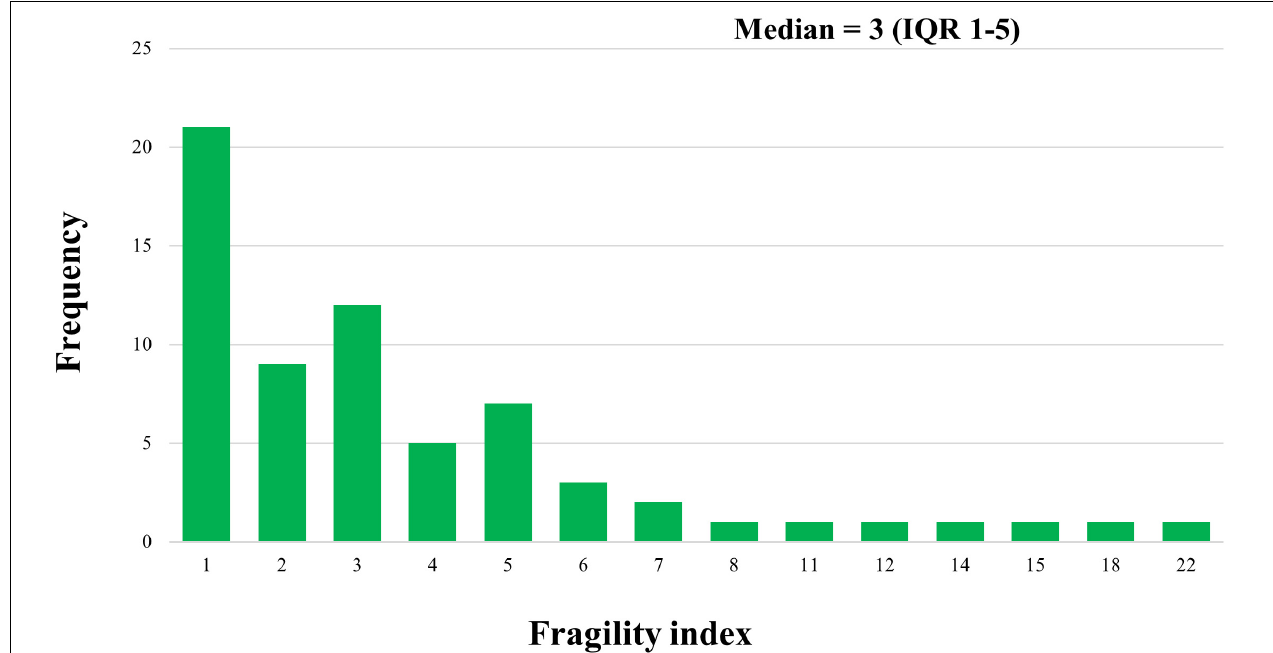
FIGURE 1 | Distribution of Fragility index across randomized controlled trials of preterm neonates. IQR: interquartile range.